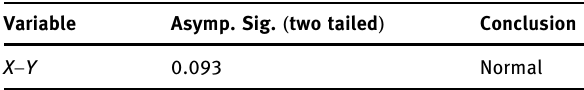
Table 3: The summary of normality test result Variable